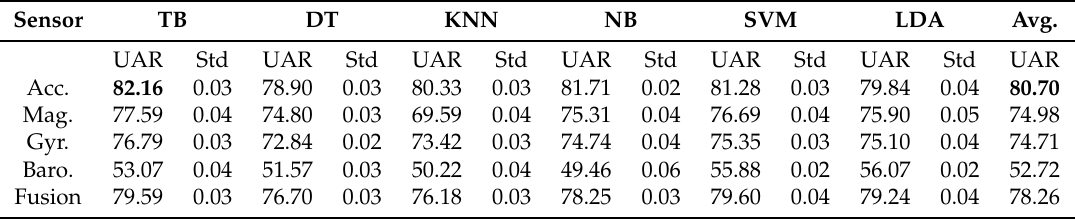
Table 5. Balanced Learning method results for non-dominant hand: Unweighted Average Recall (UAR) in % along with the standard deviation (Std) of UAR for each fold (i.e., subject) of classification. The bold figures indicate the bestresults.